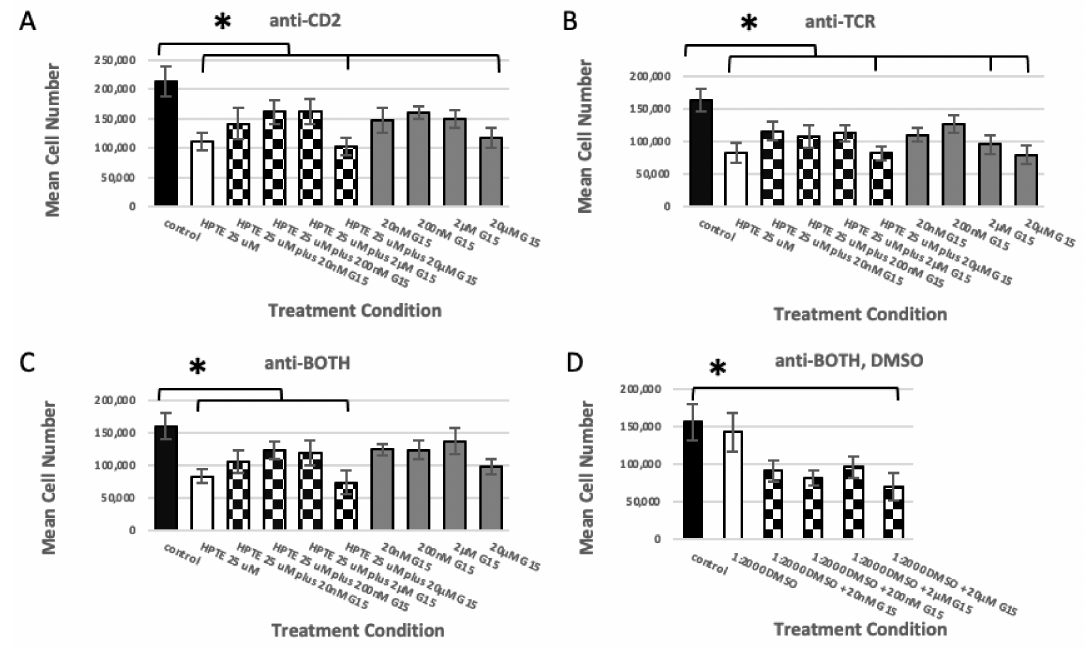
Figure 2. G protein-coupled estrogen receptor (GPER) inhibitor G15 does not rescue HPTE-treated embryonic thymocytes from cell death. Embryonic thymocytes were treated with G15 prior to and during incubation in the differentiation culture. Pre-treated thymocytes were cultured 18–24 h in the presence of the antibody listed above each panel and 25 µ M HPTE ( A – D ). N = 8, * Tukey HSD post-hoc p ≤